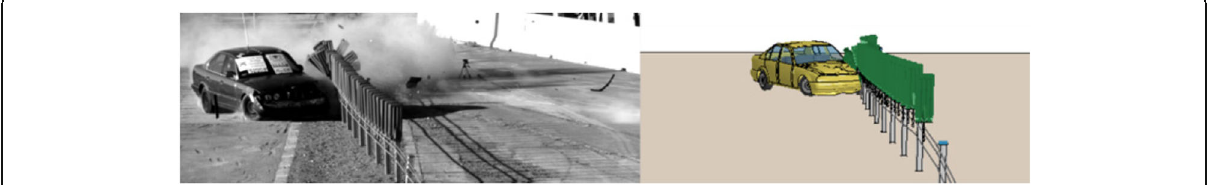
Fig. 2 Example of validation crash